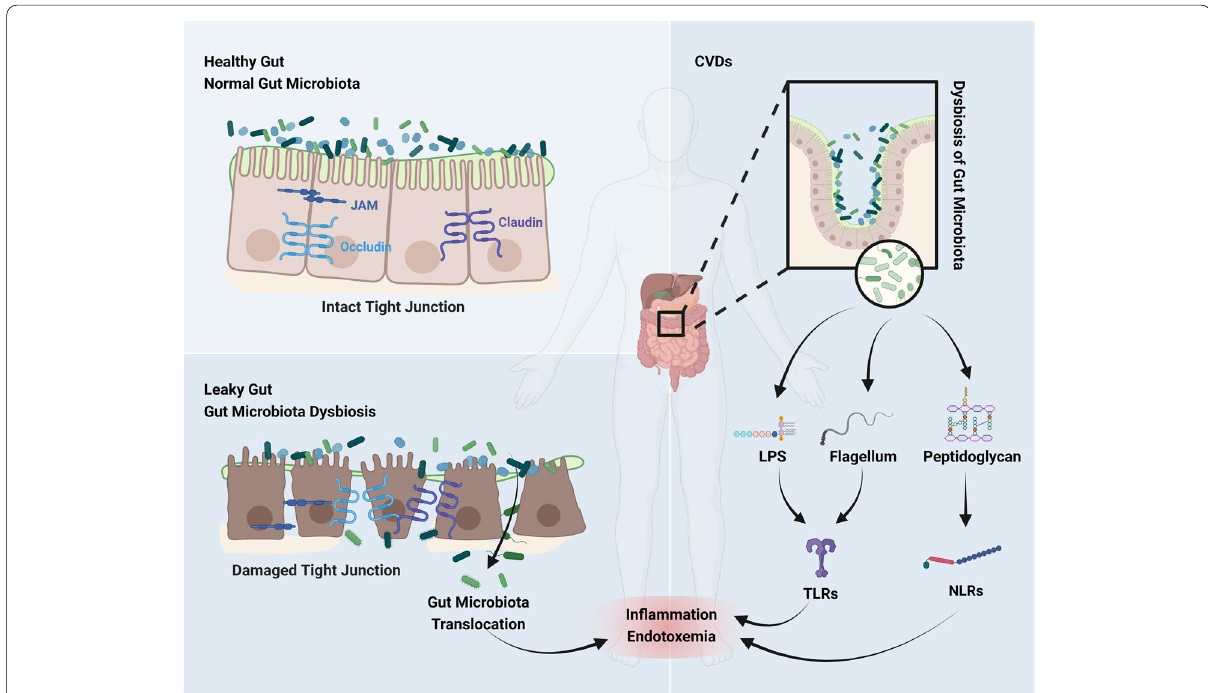
Fig. 1 The gut microbiota helps maintaining the balance of the mucosal barrier and immune homeostasis (created with BioRender.com). In the healthy gut, the intact mucosa barrier and tight junction prevent the translocation of gut microbiota, while gut microbiota dysbiosis causes disease. Under the leaky gut caused by dysbiosis, the gut microbiota translocases into the blood; the components of microbiota such as LPS activate TLRs and NLRs induce inflammation, endotoxemia, and immune dysregulation, resulting the development of CVDs. Abbreviations: JAM, junctional adhesion molecules; LPS: lipopolysaccharide; TLRs: Toll like receptors; NLRs: Nod-like